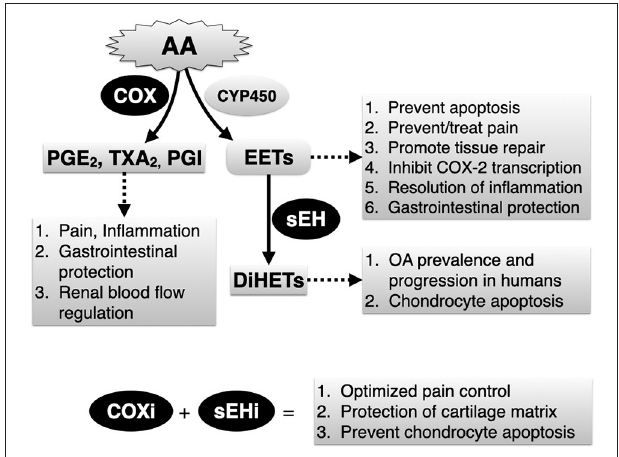
FIGURE 1 | Simplified depiction of arachidonic acid (AA) metabolism via the cyclooxygenase (COX) and the epoxygenase (CYP450) pathways. Soluble epoxide hydrolase (sEH) is a critical yet relatively unexplored enzyme that breaks down endogenously produced and beneficial epoxyeicosatrienoic acids (EETs), generated by epoxygenases to their corresponding and potentially harmful dihydroxyeicosatrienoic acid (DiHETs). Main biology related to COX and sEH activities, and expected therapeutic outcomes related to combined COX inhibitors (COXi) and sEH inhibitors (sEHi) based on results of current study are